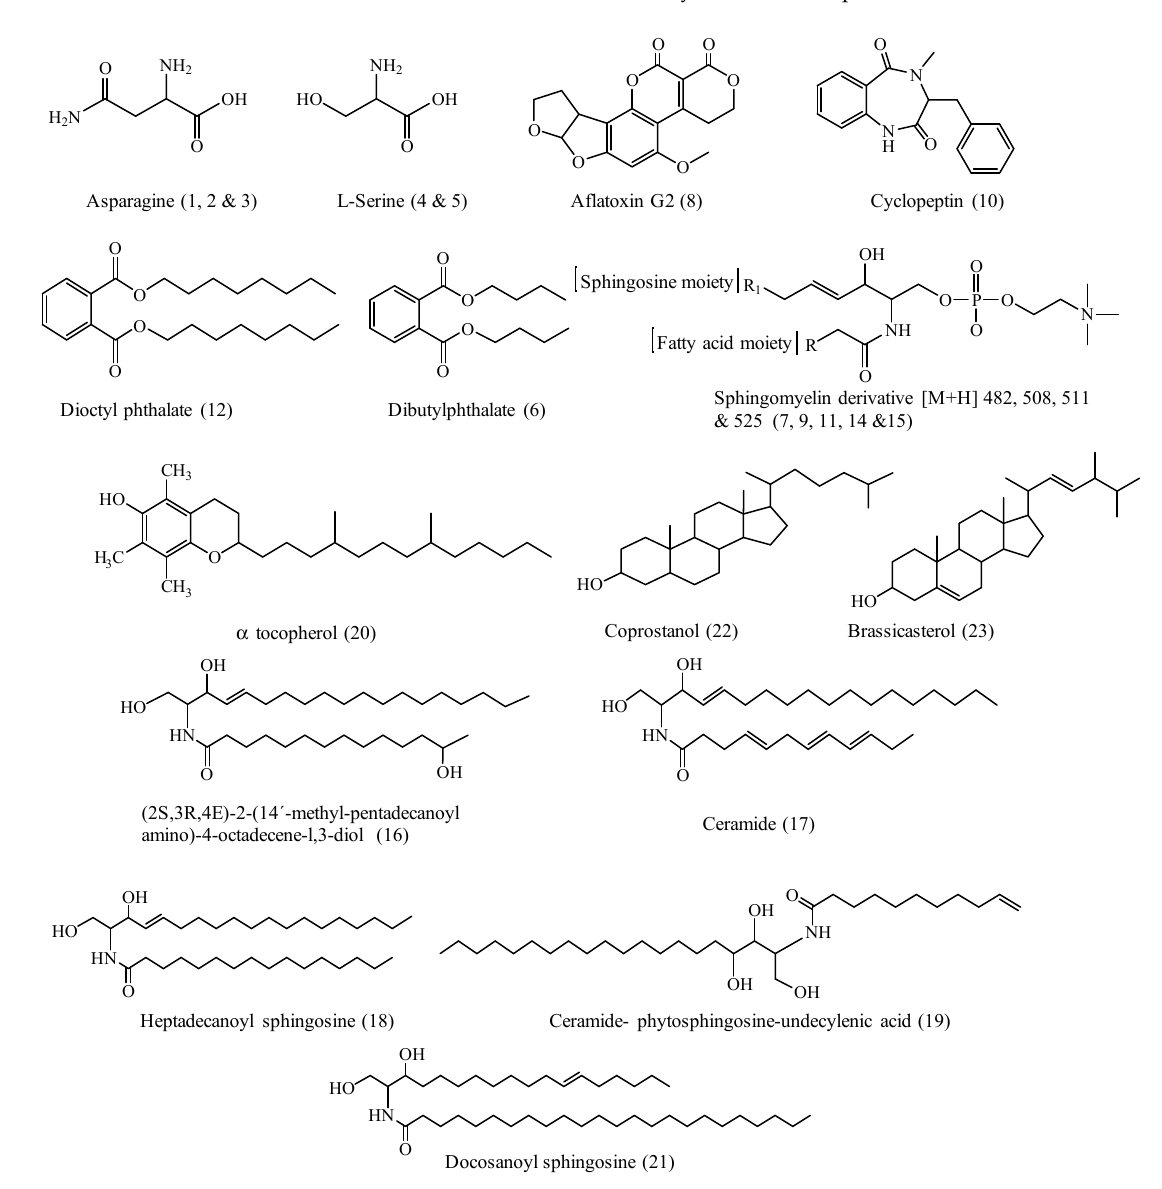
Figure 3. Chemical structures of the tentatively identified compounds from Cliona sp. n -hexane frac- tion.